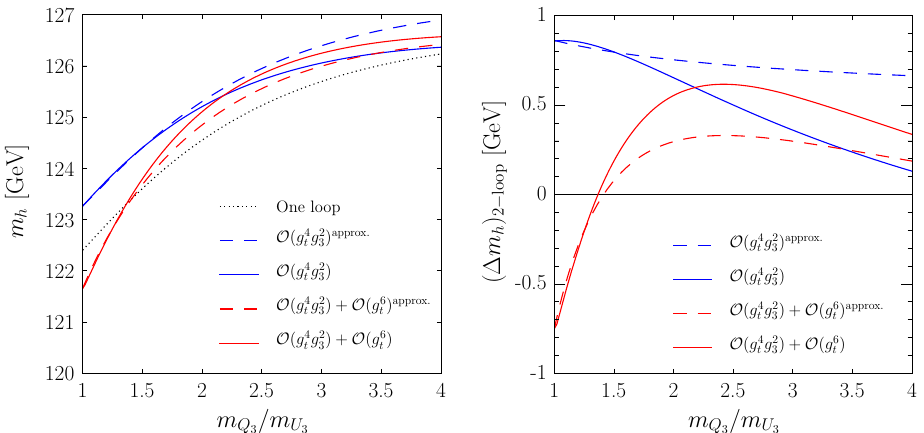
/ m m Q U 3 , while the right plot shows the shifts in m h induced by the 3 two-loop contributions alone. The choices of MSSM parameters and the meaning of the different curves are described in the